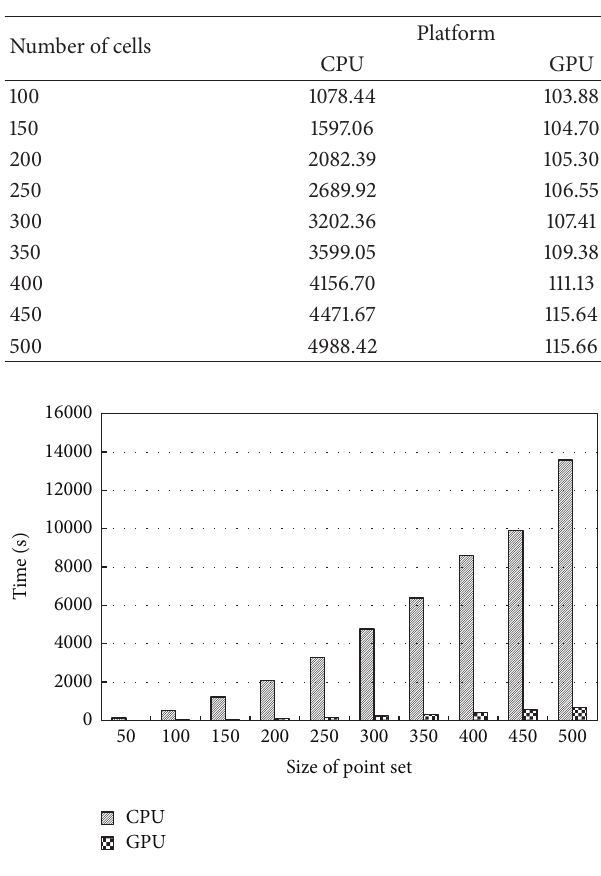
Table 1: Runtime (s) of CPU and GPU implementation of the membrane algorithm with different numbers of cells on point set matching problem having 200 points.